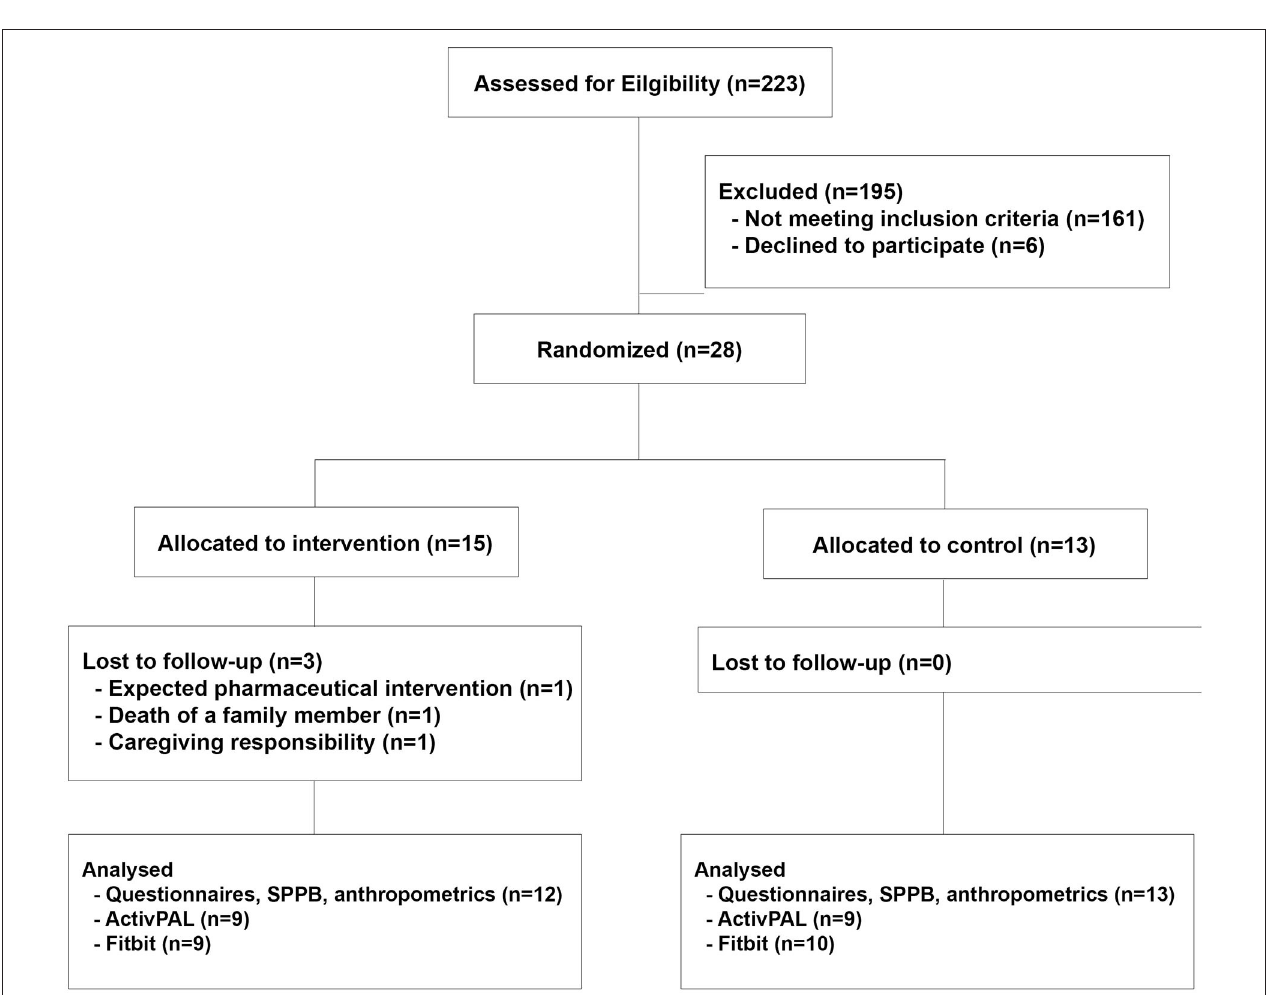
FIGURE 2 | Consort Diagram. SPPB, short physical performance